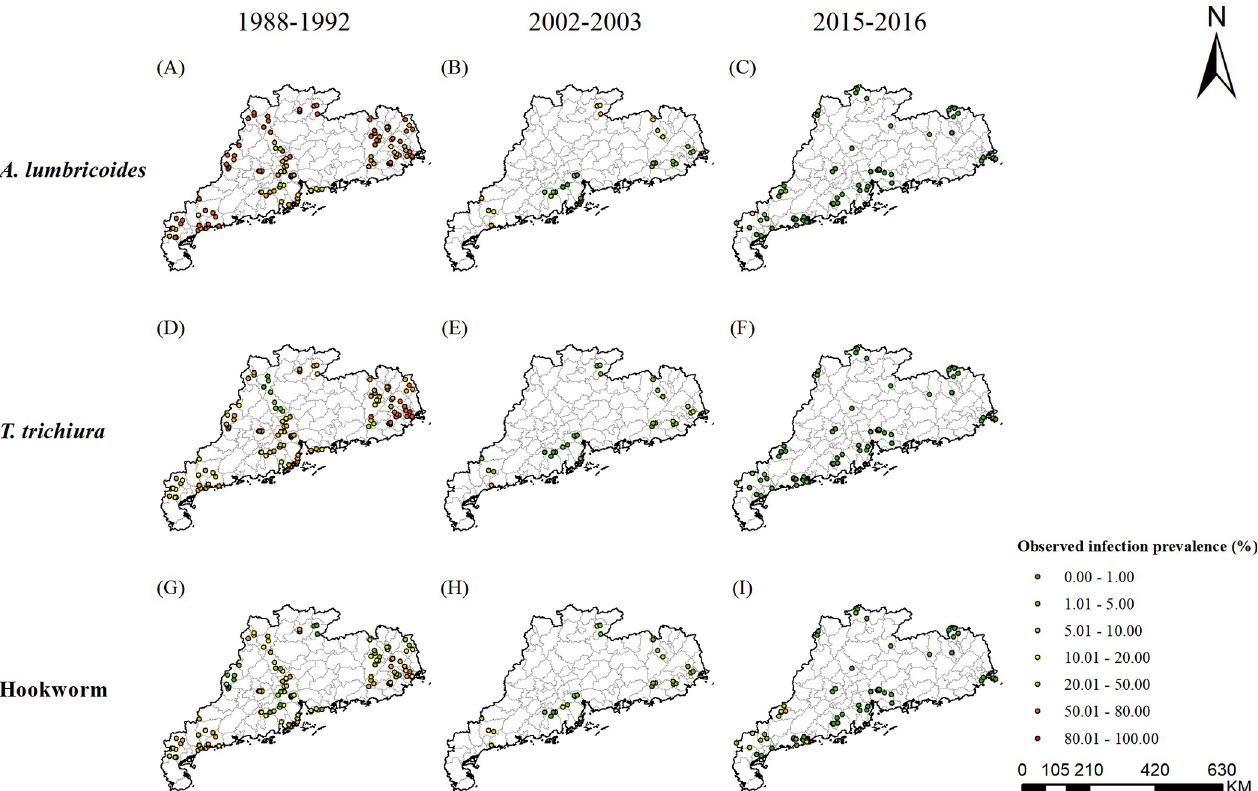
Fig 1. Survey locations and observed prevalence in Guangdong. (A)-(C) for A . lumbricoides ; (D)-(F) for T . trichiura ; (G)-(I) for hookworm, during the periods of 1988–1992, 2002–2003 and 2015–2016, respectively. The base layer derived from https://www.webmap.cn/mapDataAction.do?method= forw&keysearch=indexSearch with credit to National Catalogue Service For Geographic